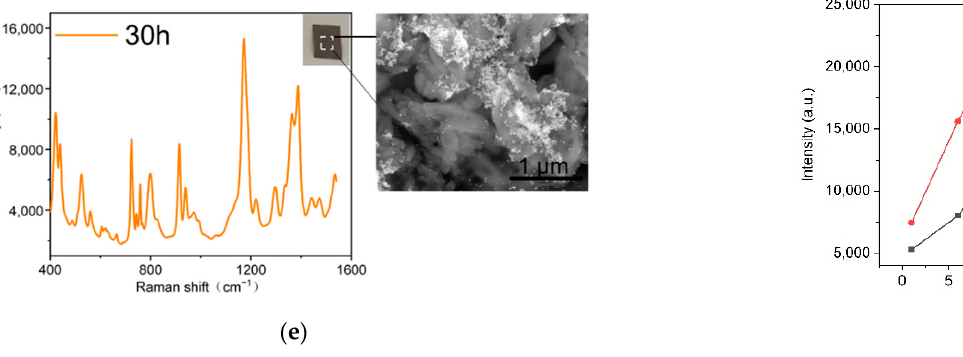
Figure 3. Optimum conditions for the preparation of the Au-TPP enhanced substrate by the immersion method. ( a – e ) SERS spectra of CV (10 − 5 M) using Au-TPP prepared using different immersion times, and related insets showing the SEM images of the Au-TPP; ( f ) the characteristic peak intensities of CV at 1171 cm − 1 and 722 cm − 1 changing with the immersion times.